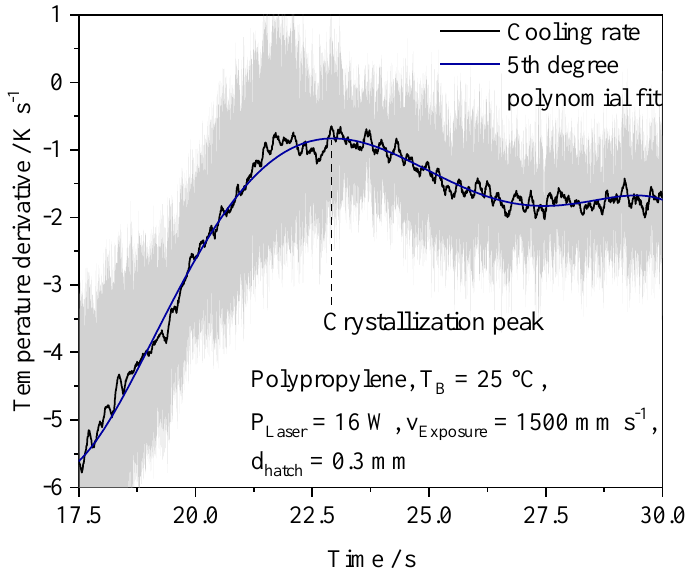
Figure 5. Exemplary depiction of the determination of thermographically represented material crystallization based on the temporal derivative of observed cooling rates.